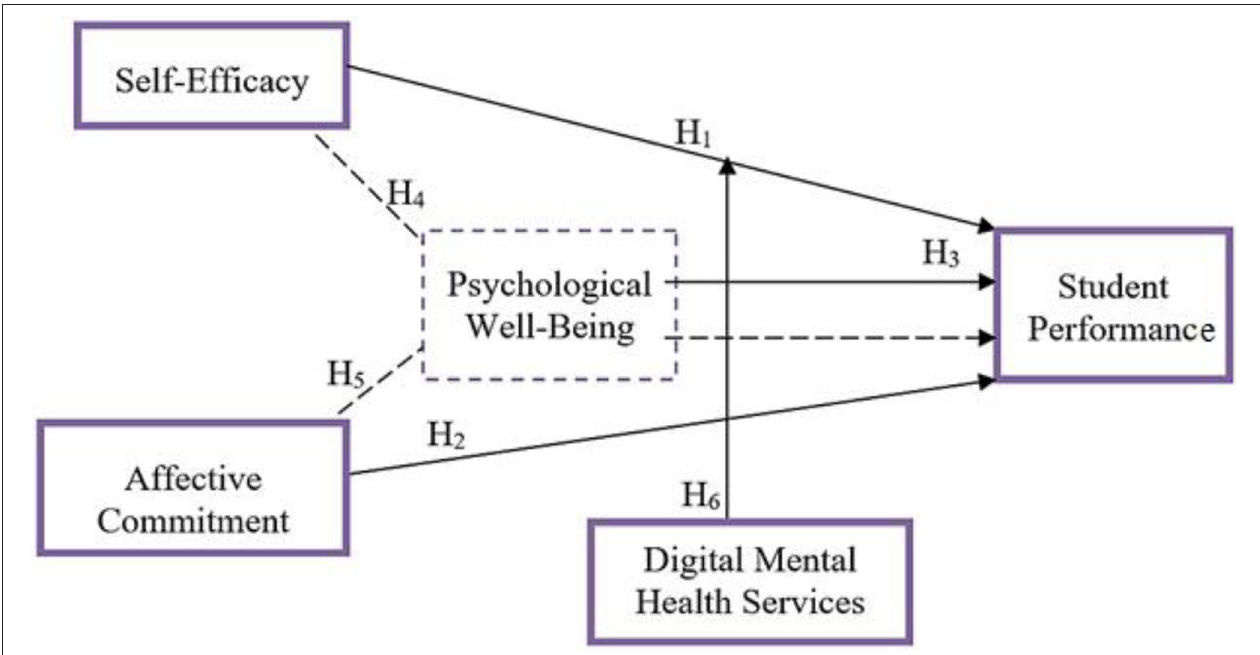
FIGURE 1 | Conceptual framework.